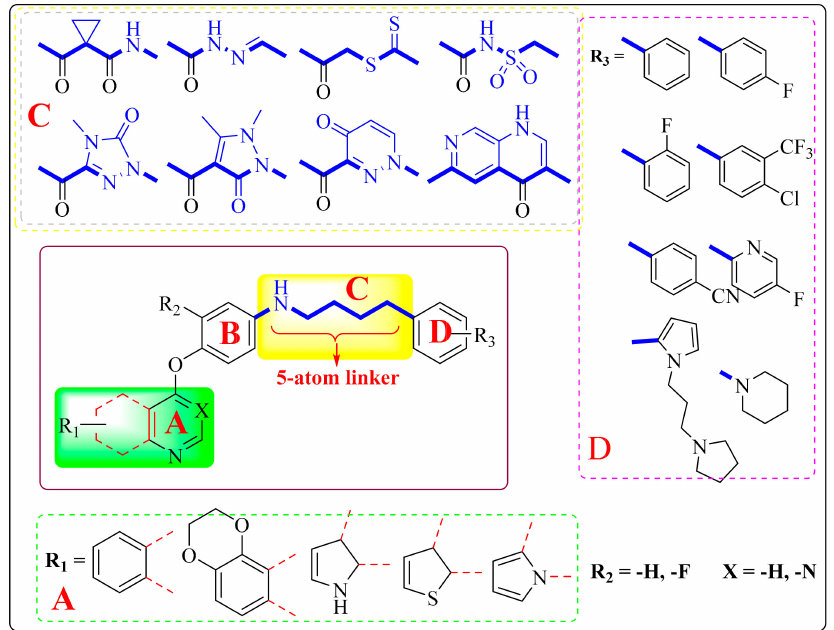
Figure 14. General structural formula of dual-target VEGFR / c-Met kinase inhibitors (Most dual-target VEGFR / c-Met inhibitors can be divided into four parts: A, B, C and D. Part A: The main structural skeleton, mainly nitrogen-containing heterocycles. Part B: Benzene ring or substituted benzene ring; Part C: Usually meet the ‘5-atom regulations’. Part D; Mostly benzene ring, substituted benzene ring or substituted pyridine ring).